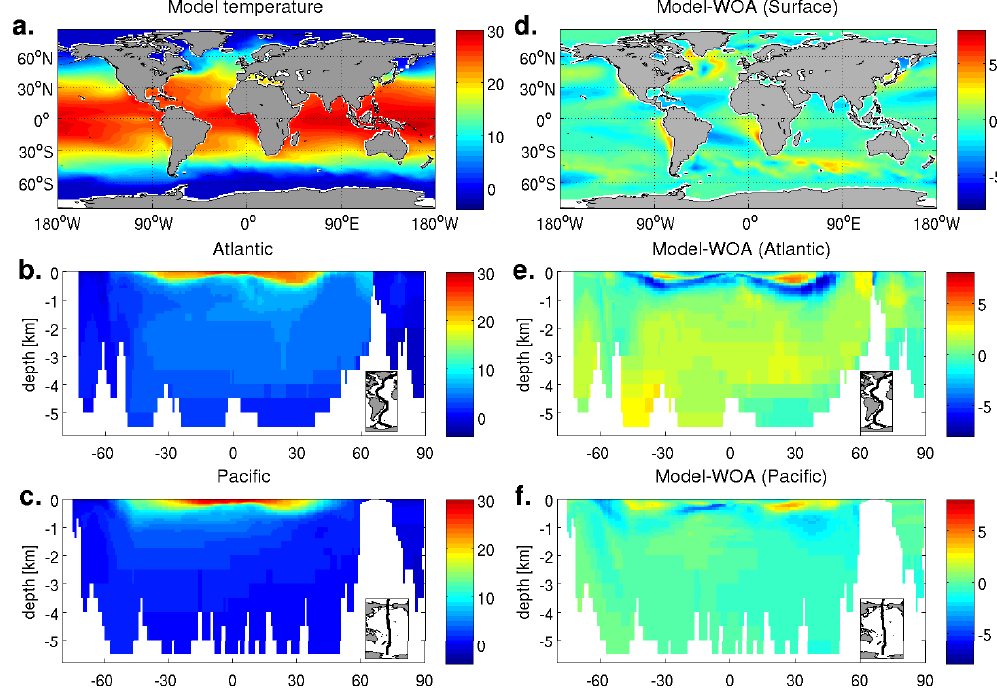
Fig. 3. Distribution of ocean temperature from model simulation (left) and difference between the model and climatological estimates (right) (WOA, Locarnini et al., 2010) for the surface (a, d) , Atlantic (b, e) , and Pacific (c, f) vertical sections. Units are in ( ◦ C).